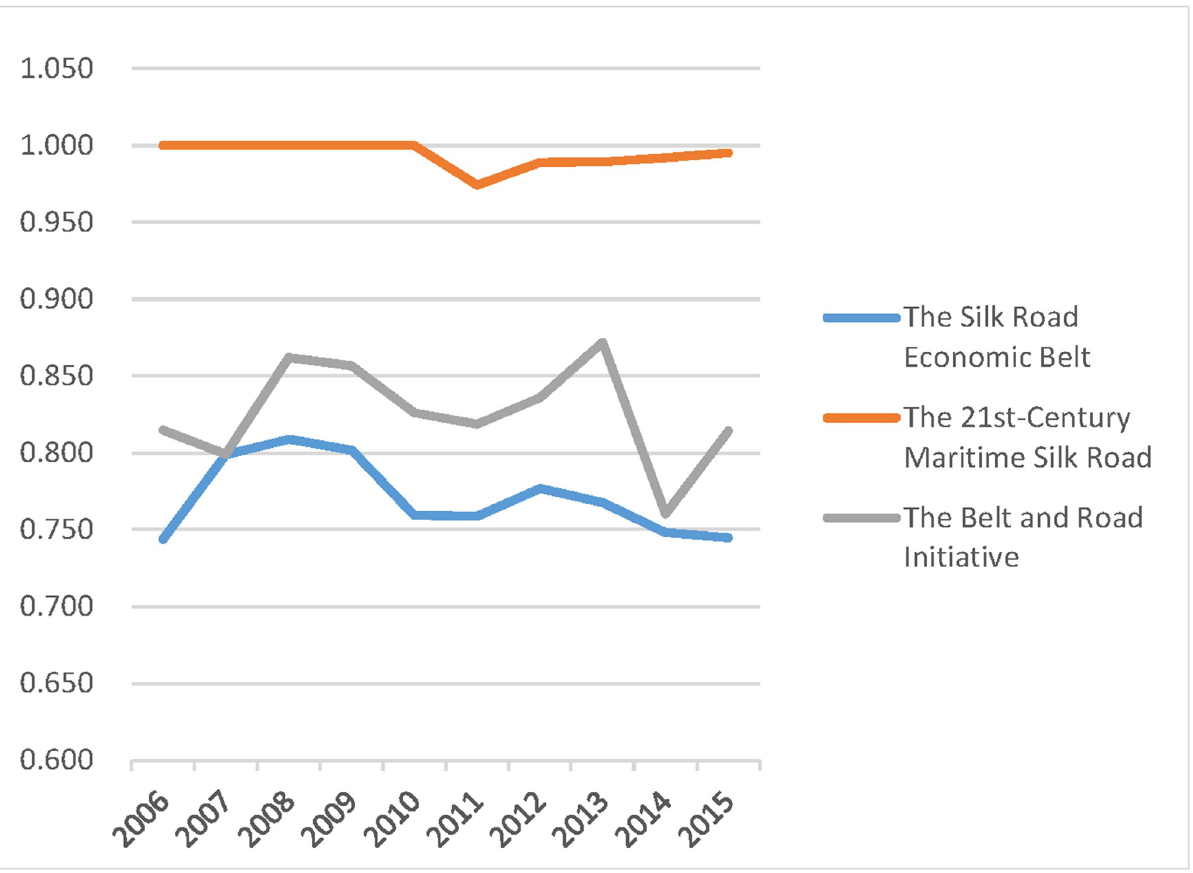
Fig 1. Comprehensive technical efficiency of different regions,